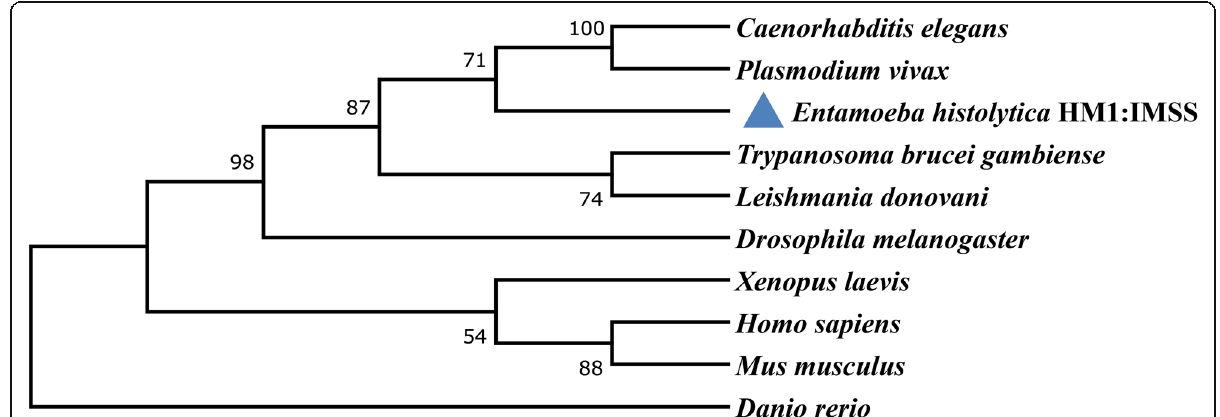
Fig. 1 Phylogenetic analysis showing the evolutionary relationship of EhApc11 with other reference organisms using the neighbour-joining method of MEGA10. The numbers below and above the branch points are indicative of the confidence level of relationships as determined by bootstrap analysis